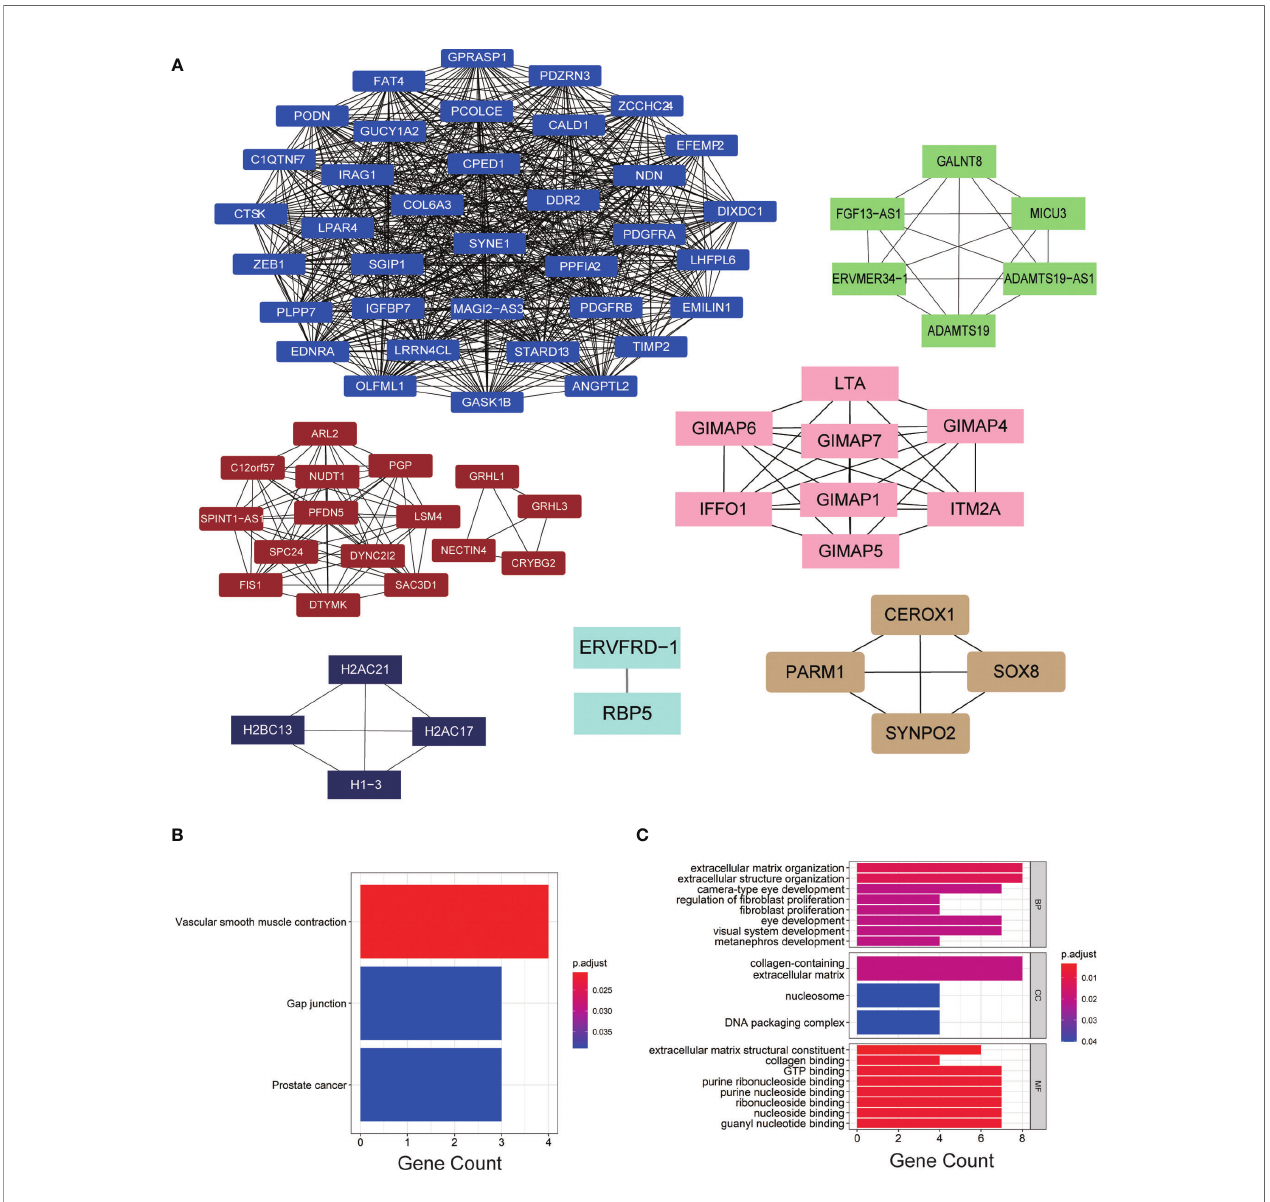
FIGURE 3 | (A) The hub genes of each module. (B, C) KEGG and GO enrichment analyses of hub genes. TABLE 2 | The signi fi cantly prognostic genes revealed by univariate and multivariate Cox proportional hazards regression analysis.